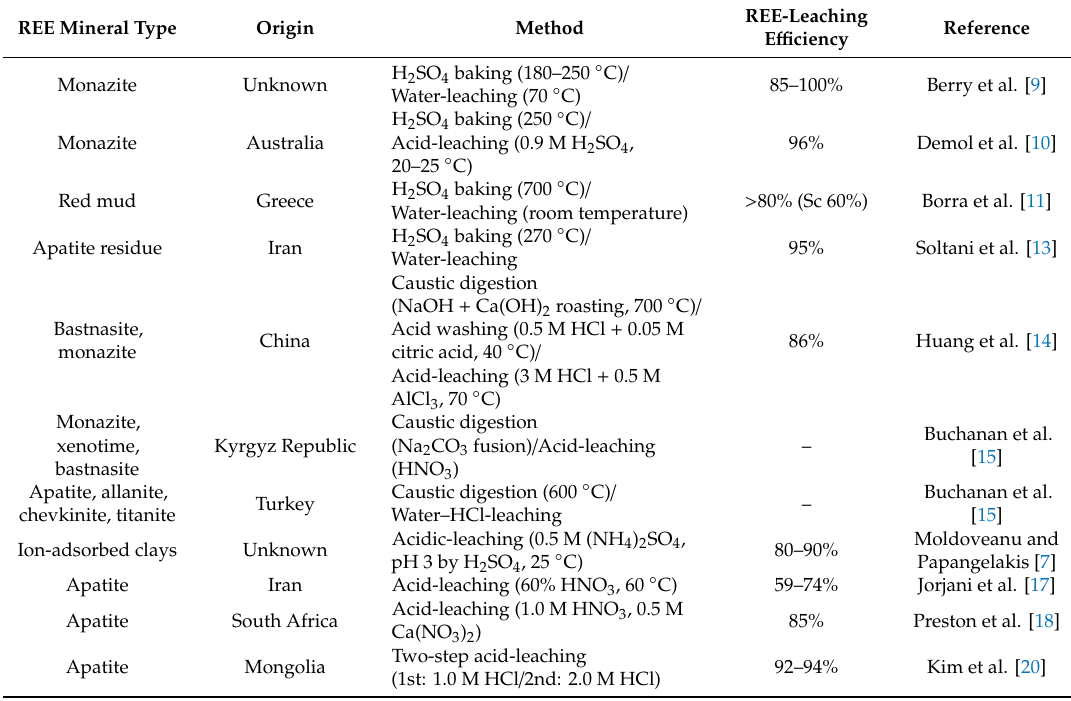
Table 1. Rare earth elements (REEs) recovery metallurgical processes.